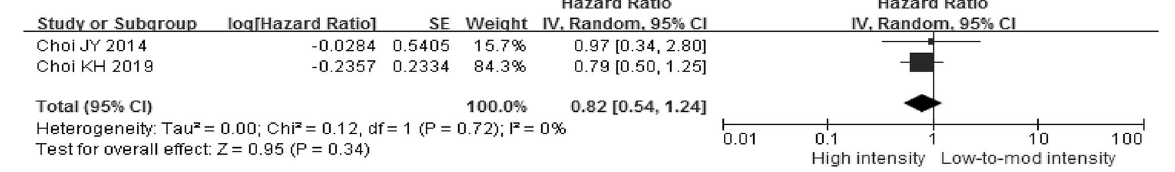
Frontiers in Neurology | www.frontiersin.org